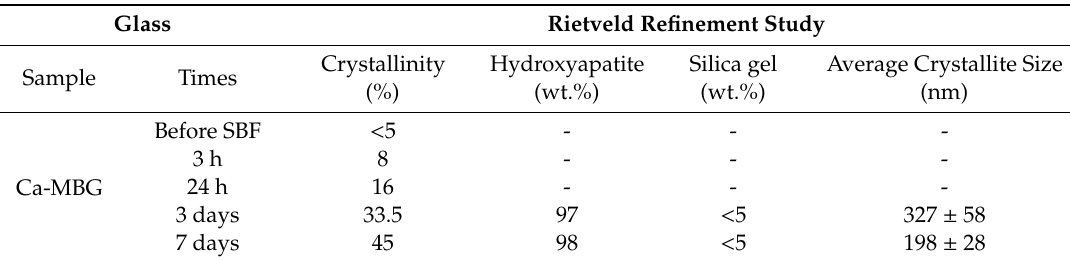
Table 2. Summary of the results of Rietveld refinement study for Ca-MBG.